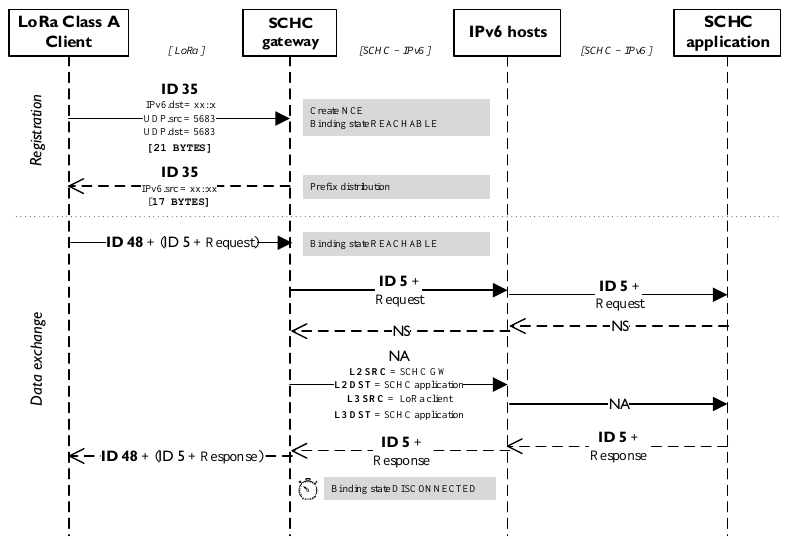
Figure 6. SCHC-based device and context registration.